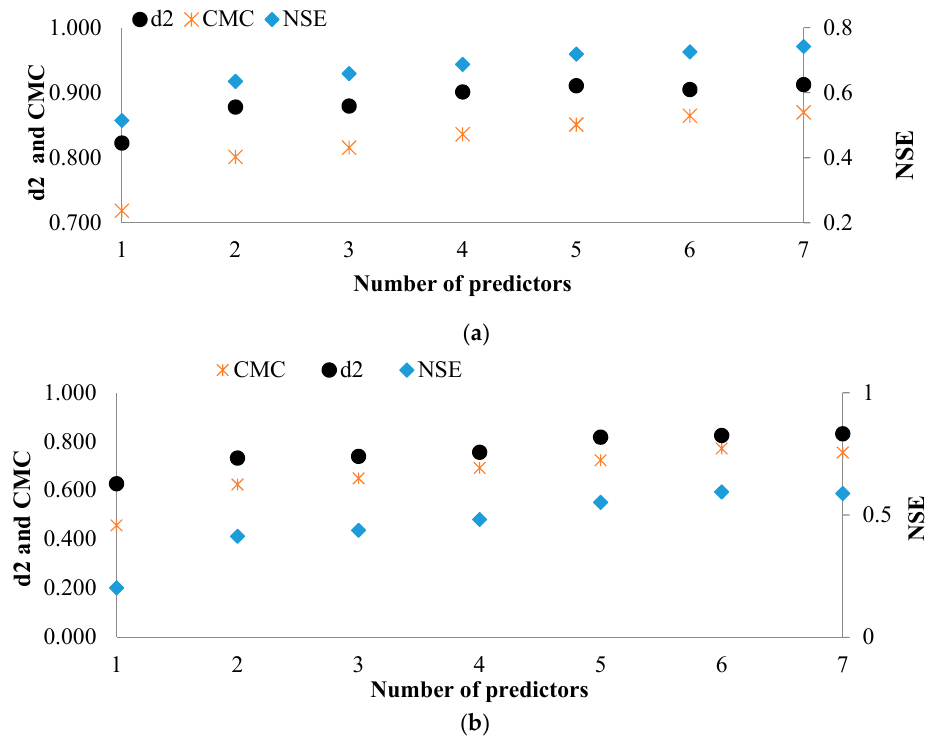
Figure 5. Increasing the rainfall forecasting performance by increasing the number of variables in the predictors’ set for TOPSIS method, ( a ) RCU and ( b ) RMAX.